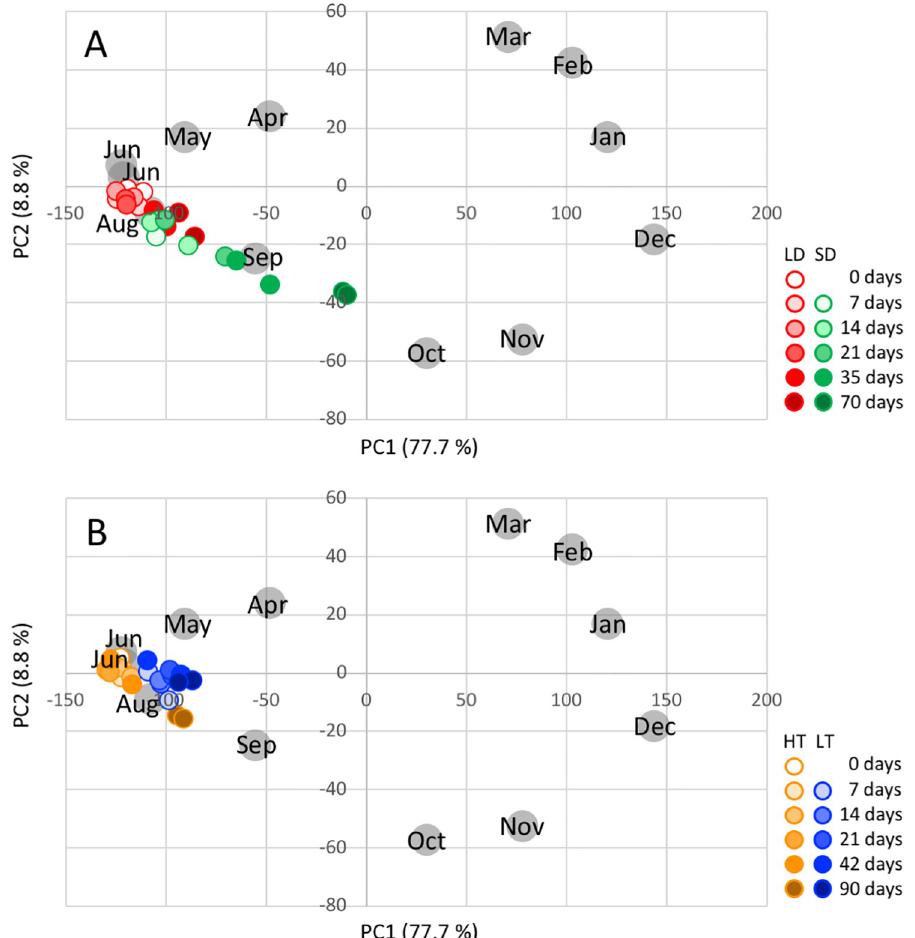
Fig 1. PCA of microarray data. The first two principal components obtained from PCA of annual time series samples of microarray data are shown (gray circles). The seasonal conditions of Japanese cedar grown in a controlled- environment chamber were estimated by plotting microarray data against the PCA results of annual time series samples. (A) Red and green circles indicate samples collected from cuttings grown under LD and SD conditions, respectively. (B) Orange and blue circles indicate samples collected from cuttings grown under HT and LT conditions, respectively.